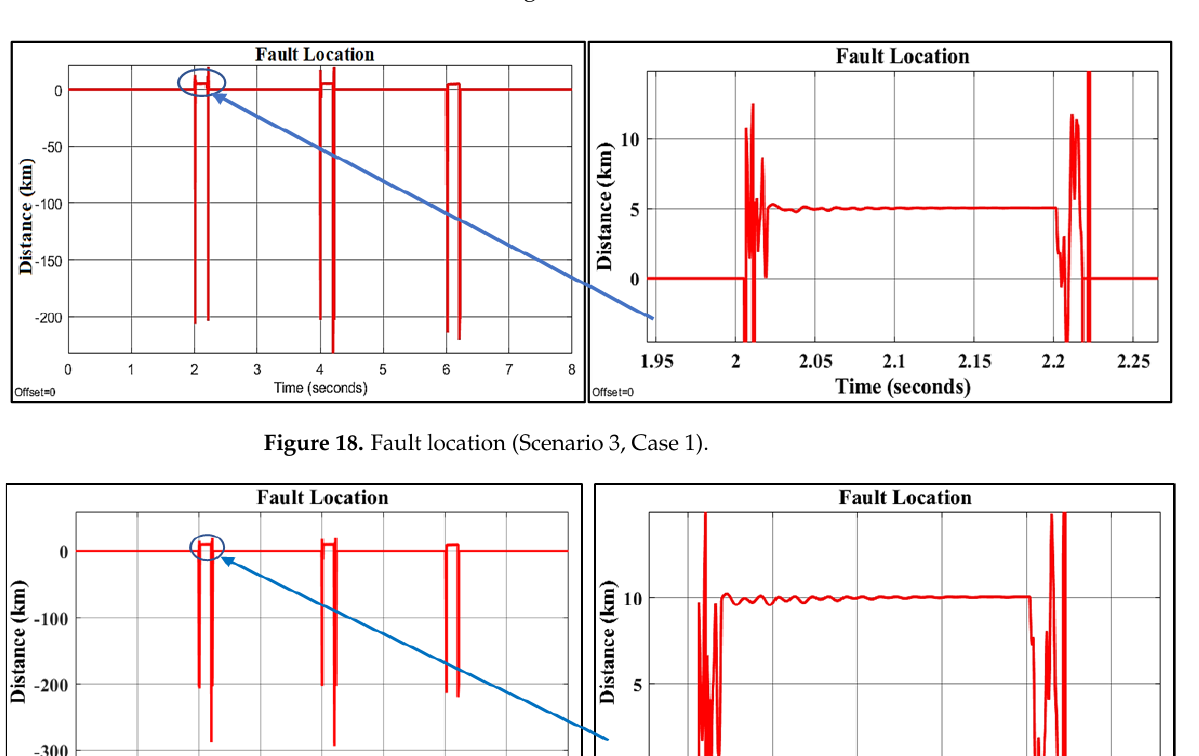
Figure 17. Fault detection and classification .